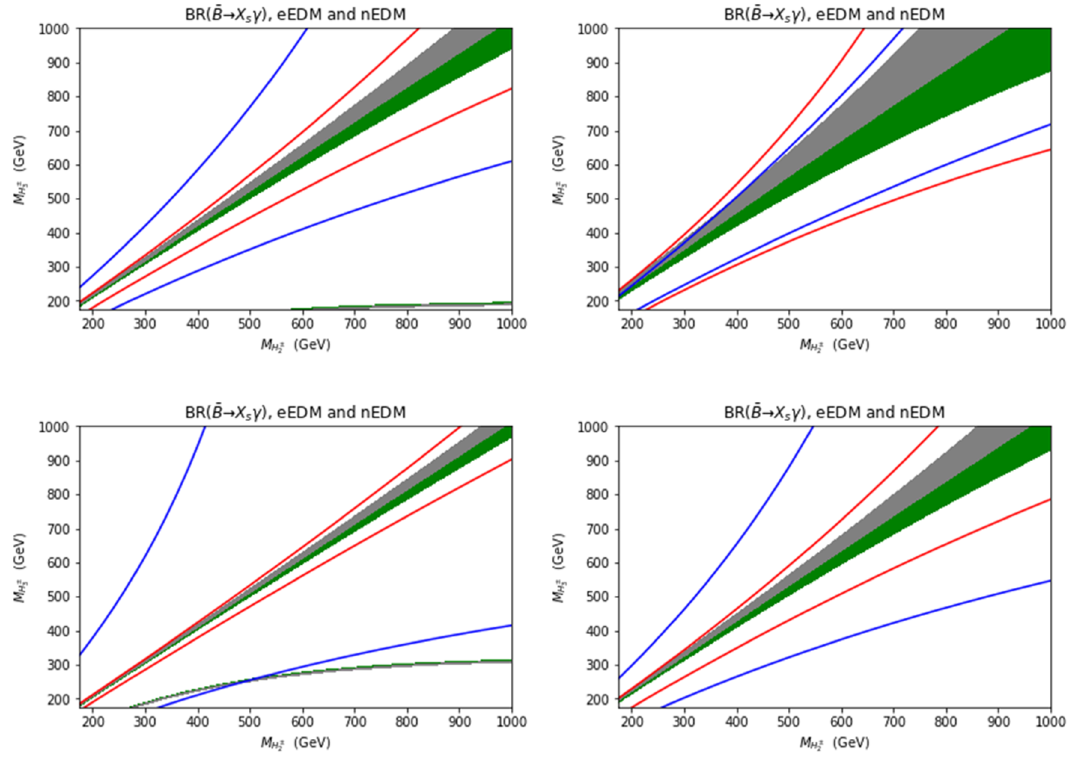
Figure 22 . Same as figure 19 but with θ = − π/ 4